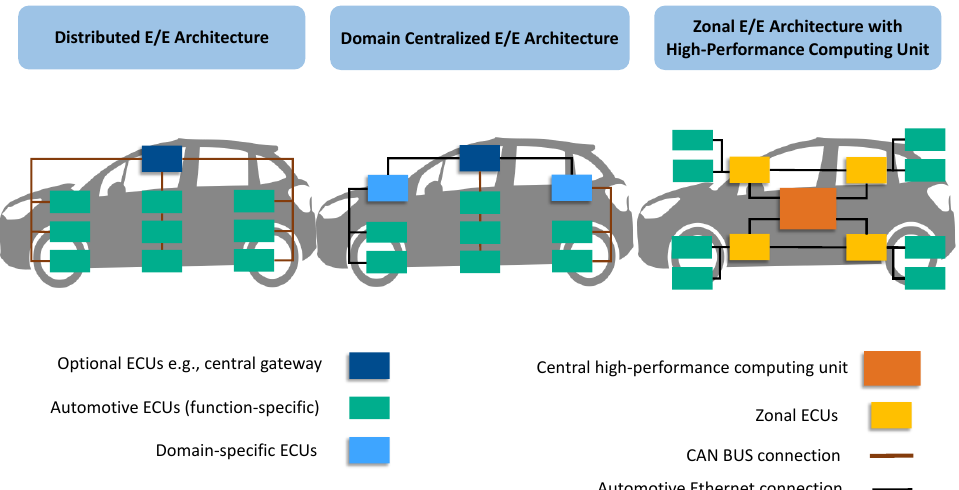
Figure 1. The figure presents the evolution of vehicle E/E architecture. Distributed E/E architecture was used until 2019, while domain-centralized architecture is today’s vehicle architecture. The zonal architecture shows the future car E/E